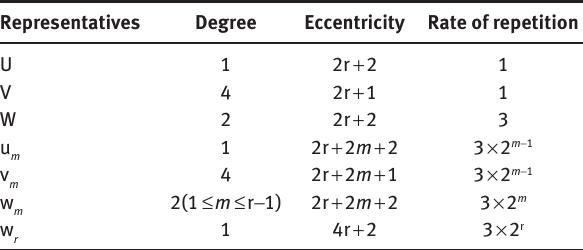
Table 2 : The characterizations of elements of V ( PD